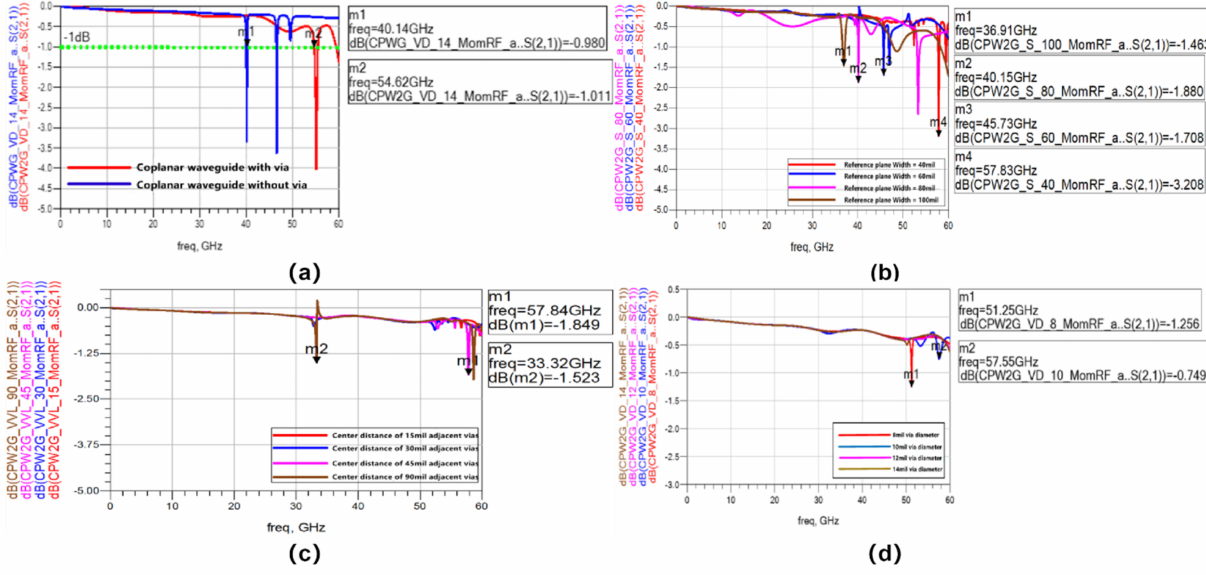
Figure 11. ( a ) Comparison of insertion loss of strip coplanar waveguide with via (red line, the best parameters are not used) and without via (blue line); ( b ) comparison of insertion loss of coplanar waveguide with different width W; ( c ) comparison of insertion loss of coplanar waveguide with the center distance between the connected vias VVL under best parameter W = 40 mil; ( d ) comparison of insertion loss of coplanar waveguide with the diameter of vias VD under best parameters W = 40 mil, VVL = 30